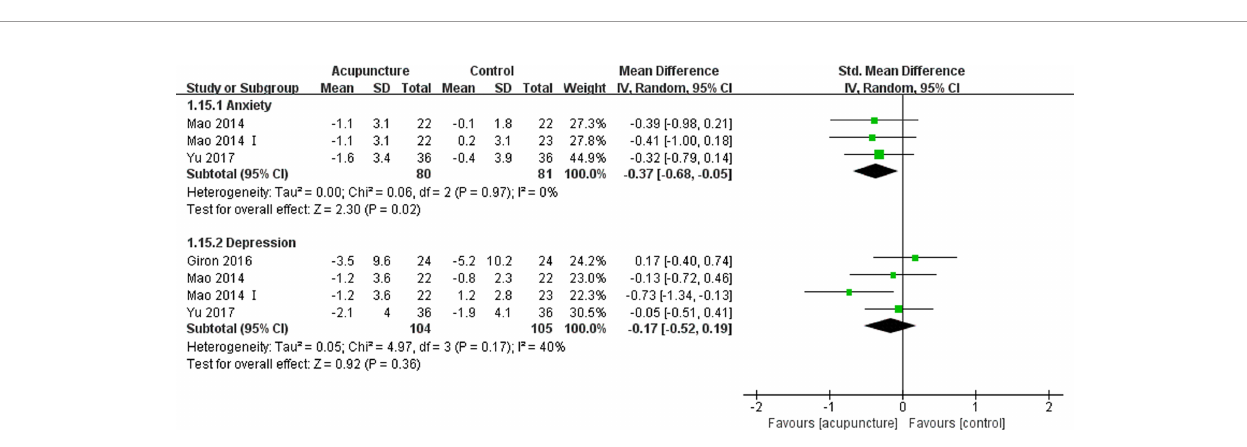
FIGURE 6 | Forest plot of the change of anxiety and depression in BC patients treated with acupuncture and control from the bassline to end of treatment. IV, inverse variance; CI, Con fi dence Interval. The Roman numerals “ I ” followed the study ID represented the comparison of acupuncture versus no intervention in the study which had three